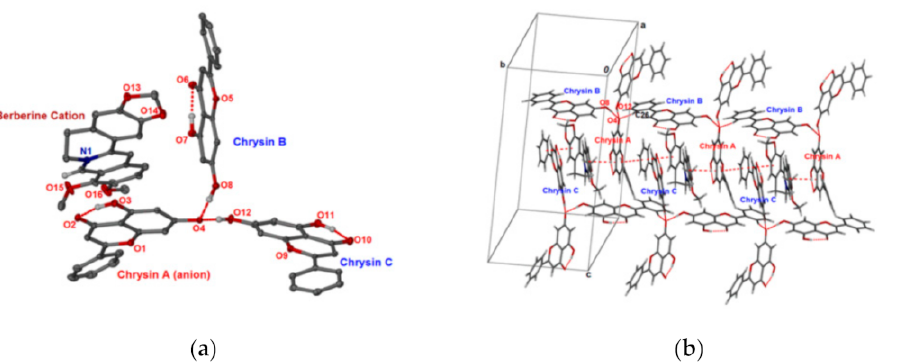
Figure 5. ( a ) ORTEP plot of berberine–chrysin cocrystal with 35% probability level. H atoms on C were omitted for clarity. Dashed lines represent hydrogen-bonding interactions. ( b ) Supramolecular structure resulting from C–H · · · O and π – π interactions [66] (adapted with permission from [66]; Copyright 2018 American Chemical